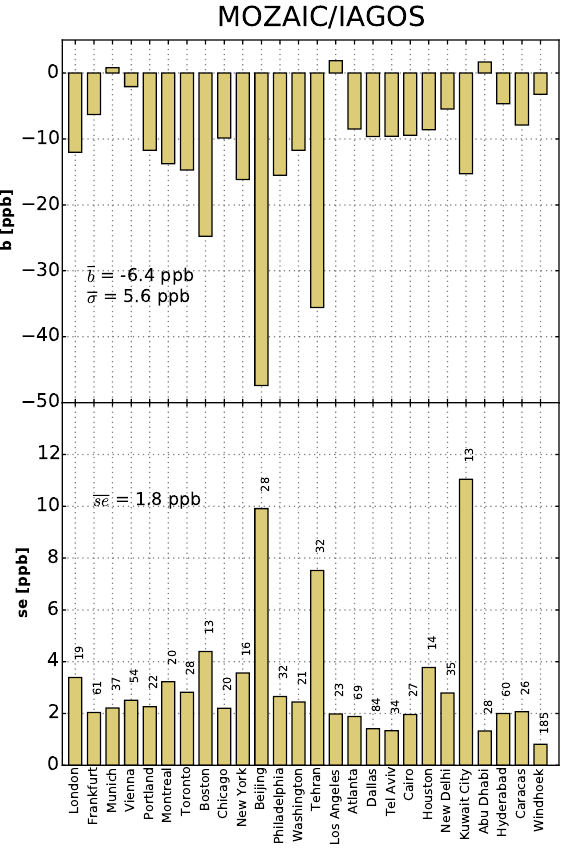
Figure 10. As Fig. 8, but for MOZAIC/IAGOS measurements.